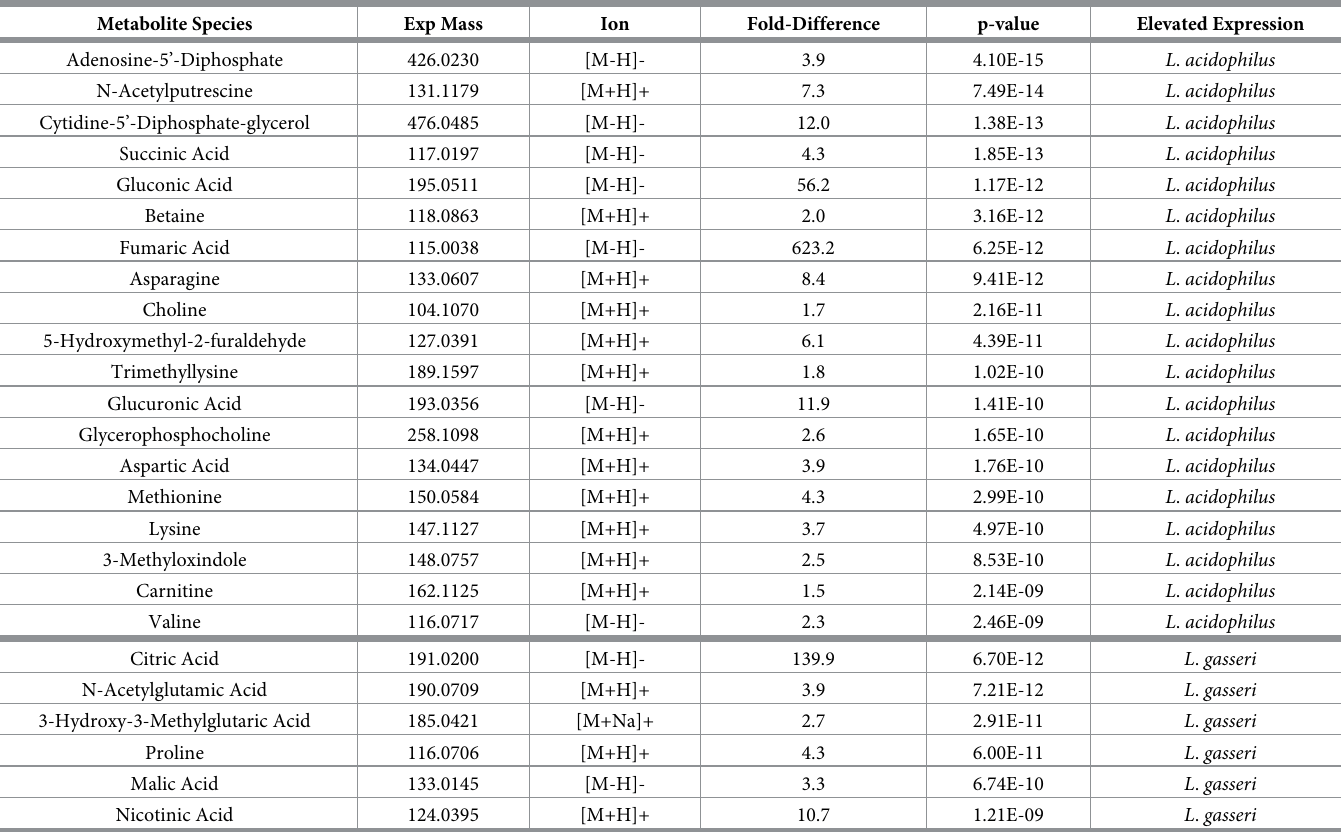
Table 1. Top-25 identified metabolites of greatest significant difference in signal intensity between L . acidophilus and L . gasseri